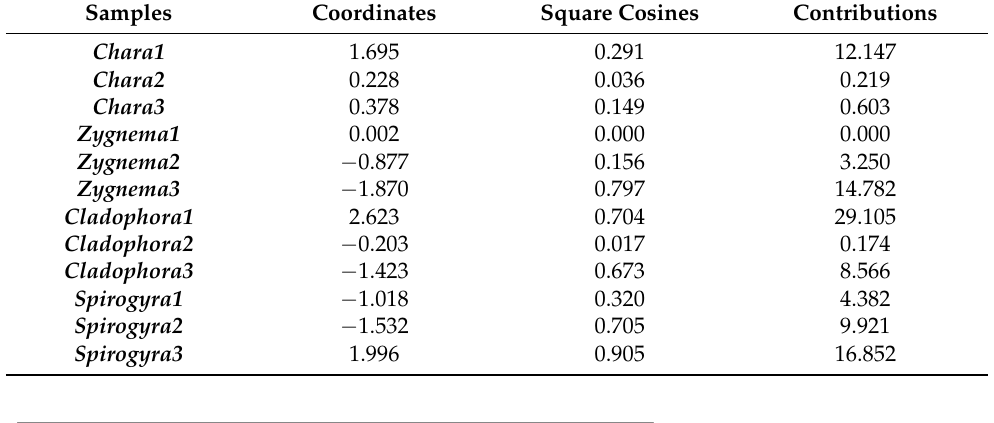
Table 3. Explanatory points for axis one.